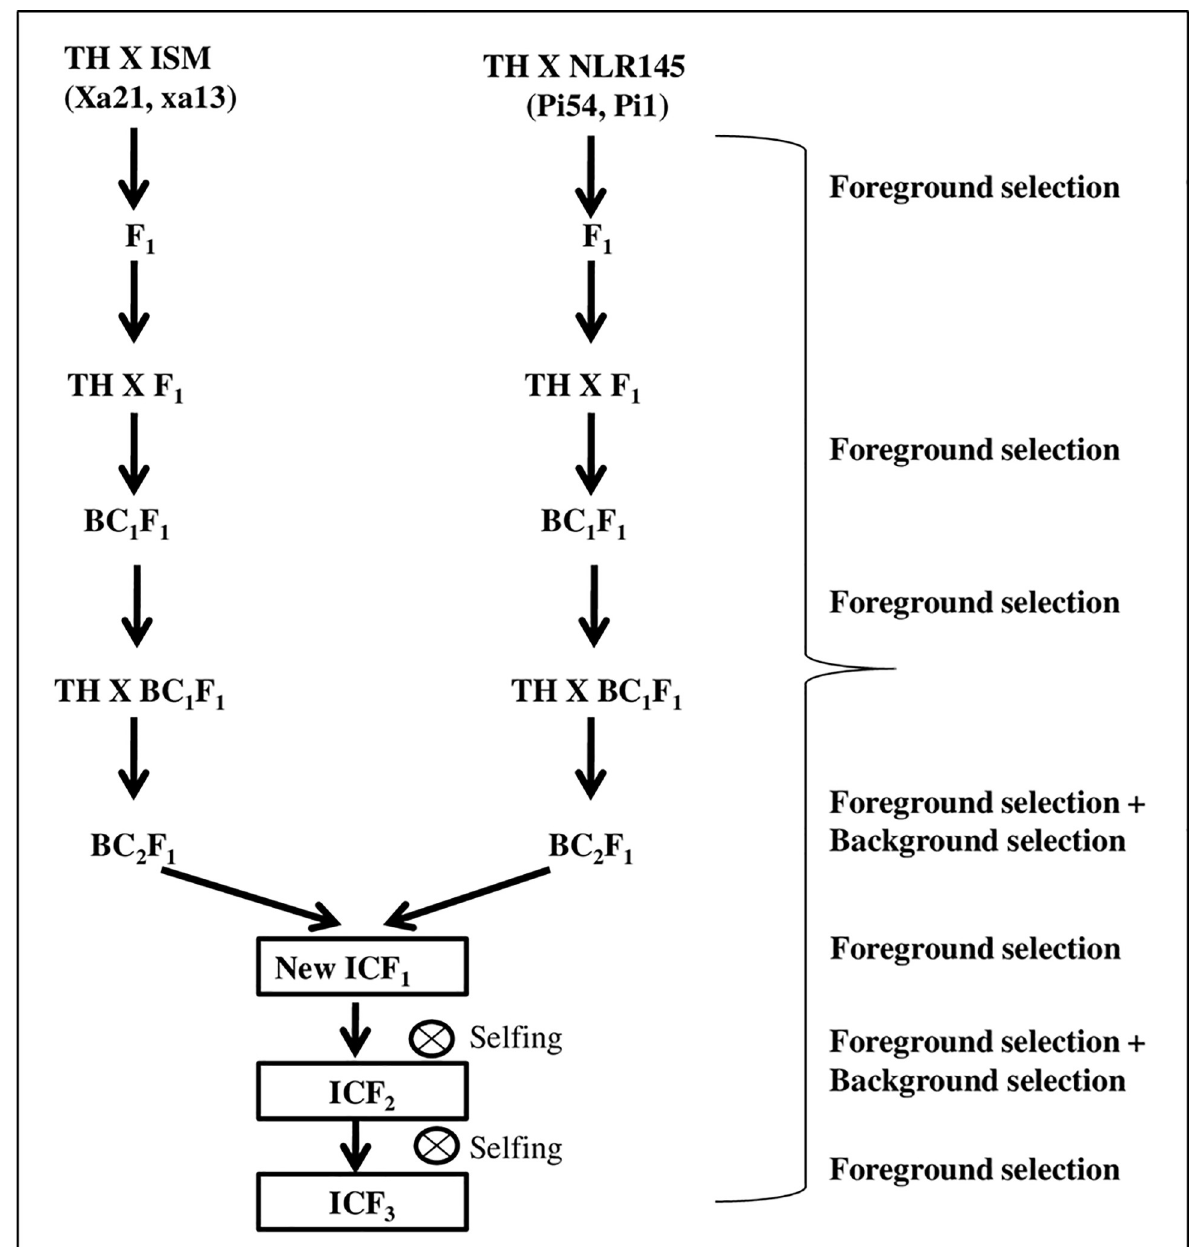
Fig 1. Marker assisted backcrossing scheme adopted in the study. 0.01mg/ml gelatin) and 0.5U of Taq DNA polymerase (JONAKI) in a reaction volume of 10 μ l. Amplification cycling was performed in a gradient programmable master cycler (Veriti, Applied Biosystems). The PCR condition was with one cycle of denaturation at 95˚C for 5 min, followed by 35 cycles at 95˚C for 45s, 55˚C for 45s, and 72˚C for 1 min, and with a final extension at 72˚C for 10 minutes. The final PCR products were resolved by electrophoresis on